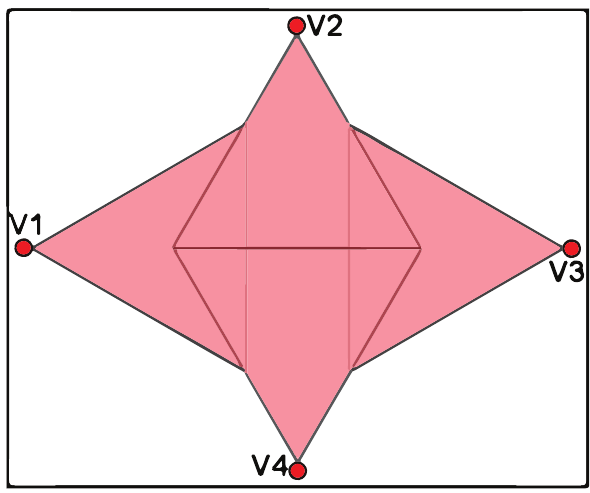
Figure 3. WVSN for area coverage.